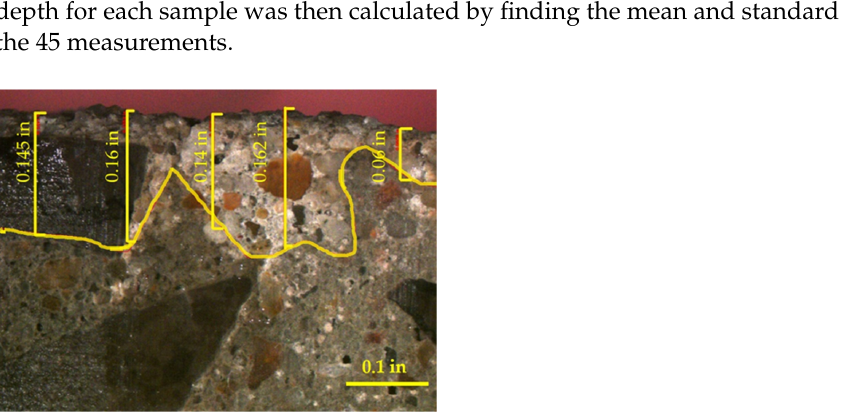
Figure 2. Silane coating profile under a digital microscope with measurements at nine polished spots (1 in = 25.4 mm).